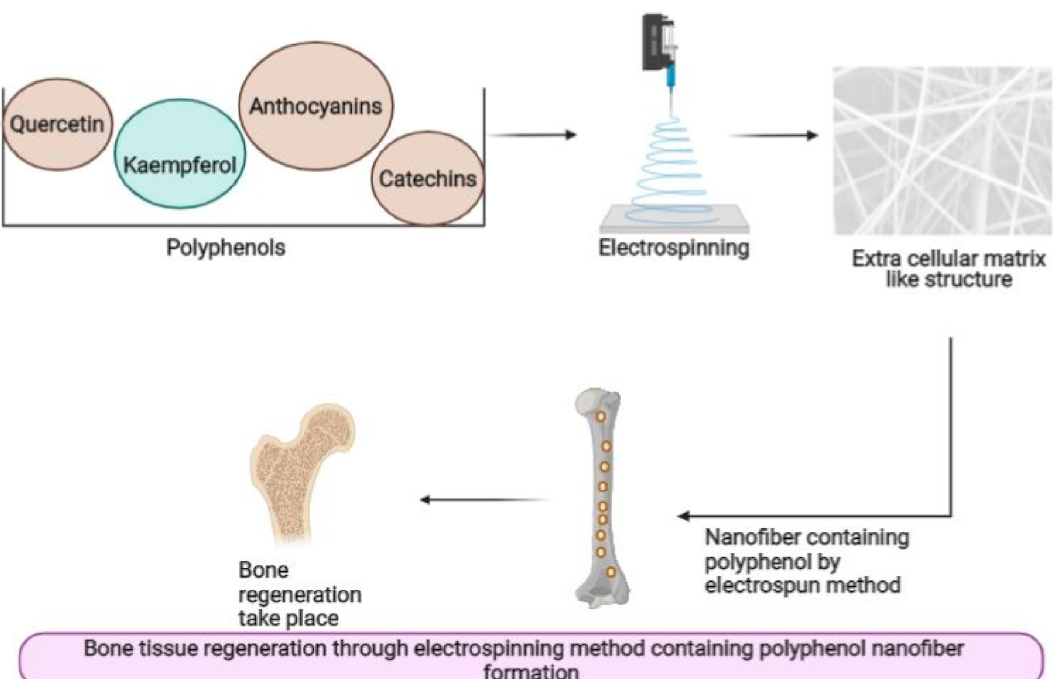
Figure 5. Schematic representation of bone tissue regeneration process through electrospinning method containing photo-bioactive (polyphenol) nanofiber